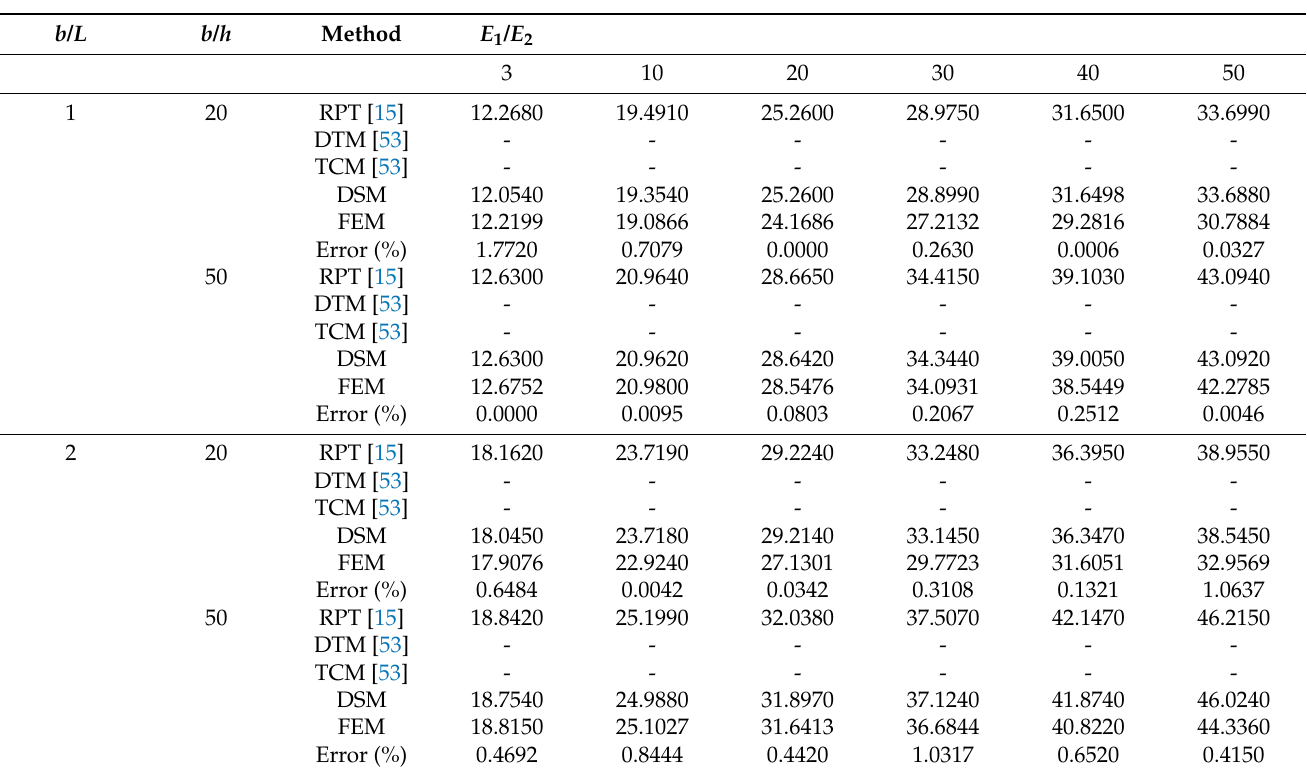
(cid:113) ρ (cid:16) (cid:17) (cid:118) = ω b 2 of an orthotropic E 2 h